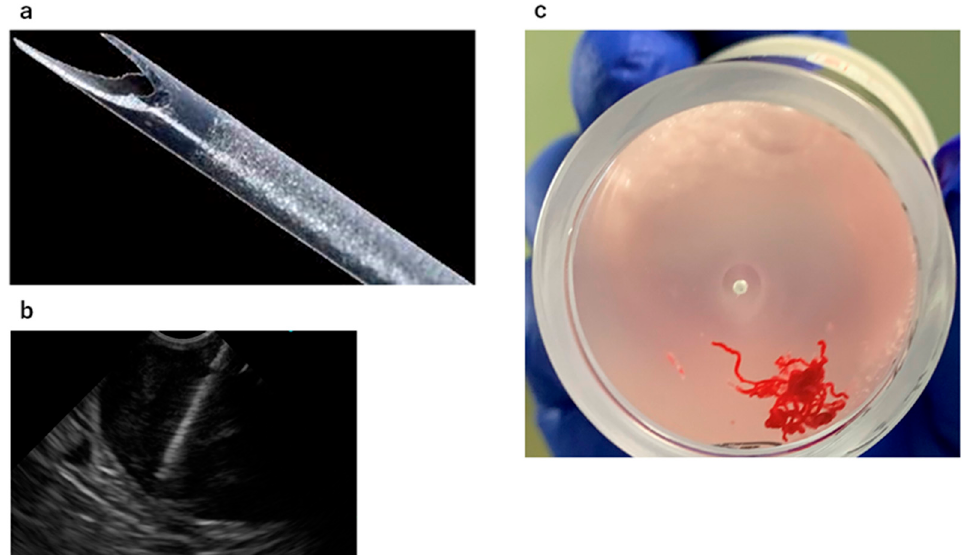
Figure 1. The features of a fork-tip needle. ( a ) The tip of the fork-tip needle is split in two like a shark’s fin. The effect of this structure is to improve the puncture ability to penetrate the stomach wall. ( b ) EUS imaging of a fork-tip needle punctured into a SEL. The needle tip is sandblasted for improved visibility under ultrasound imaging. ( c ) The tissue specimens for histological diagnosis obtained by two punctures of EUS-FNB with the fork-tip needle. Some long and filamentous specimens were also obtained.